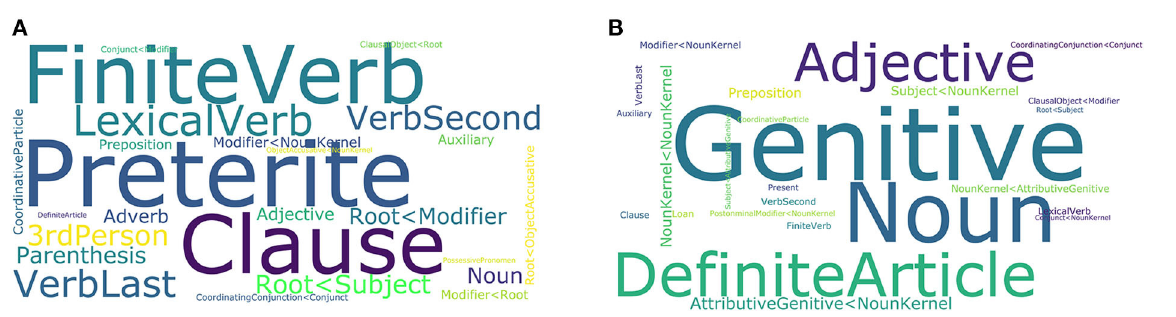
FIGURE3 Project A04: Prominent grammatical features in two potential registers; (A) containing stories/accounts of events, (B) containing laws/texts on jurisprudence; font size corresponds to probabilities within the potential register.